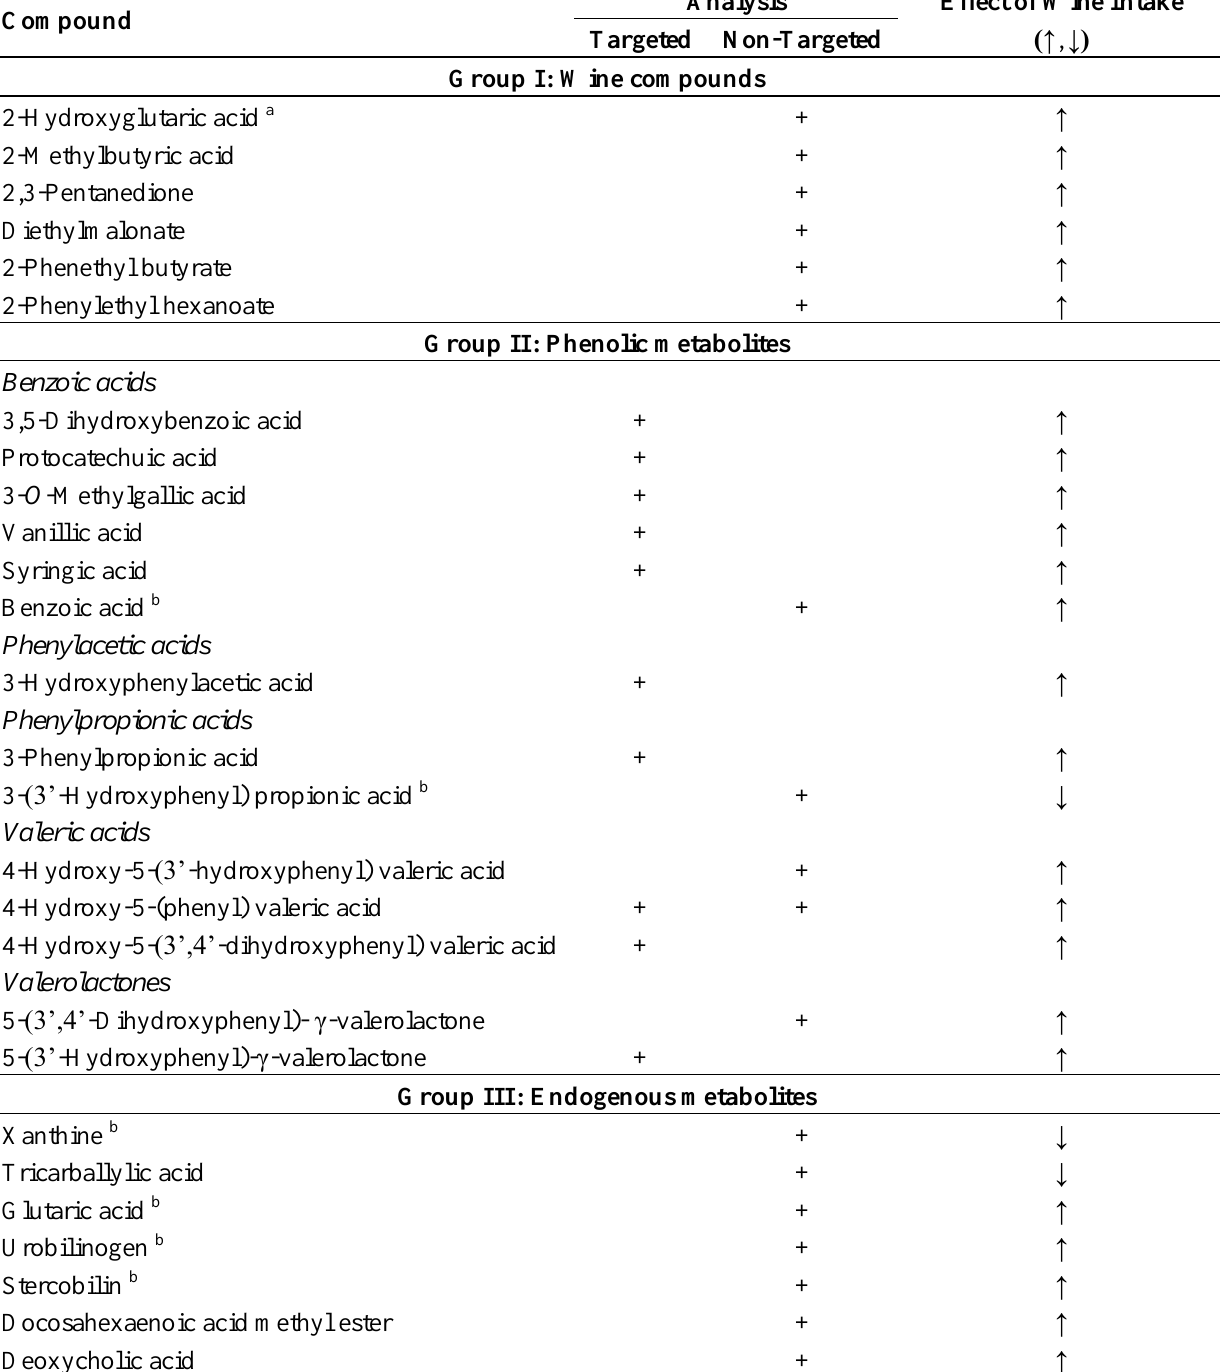
Table 1. Fecal metabolites significantly regulated by moderate wine consumption.